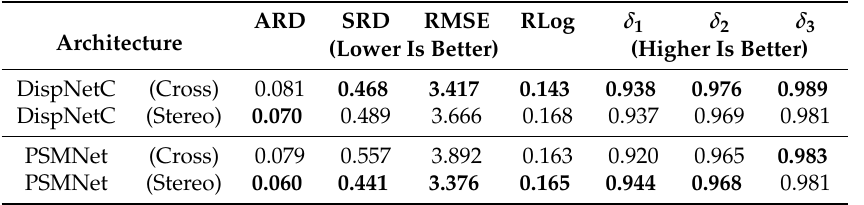
Table 3. Quantitative results of stereo matching.